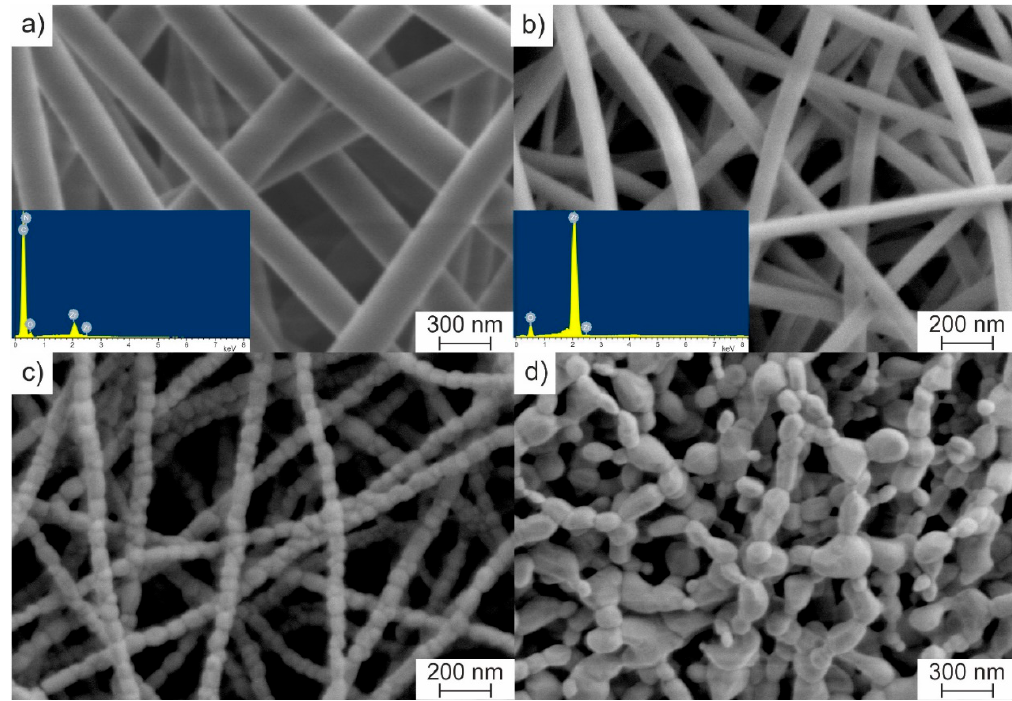
Figure 1. SEM images of zirconium acetylacetonate/polyacrylonitrile (ZrAA/PAN) fibers ( a ) as-spun, and calcined at ( b ) 500, ( c ) 1100, and ( d ) 1300 °C. The inserts show their energy-dispersive X-ray spectrometer (EDS) spectra at appropriate temperatures.